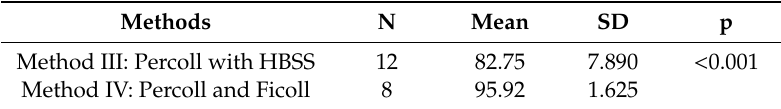
Table 5. Purity analysis of granulocytes isolated by methods III and IV.